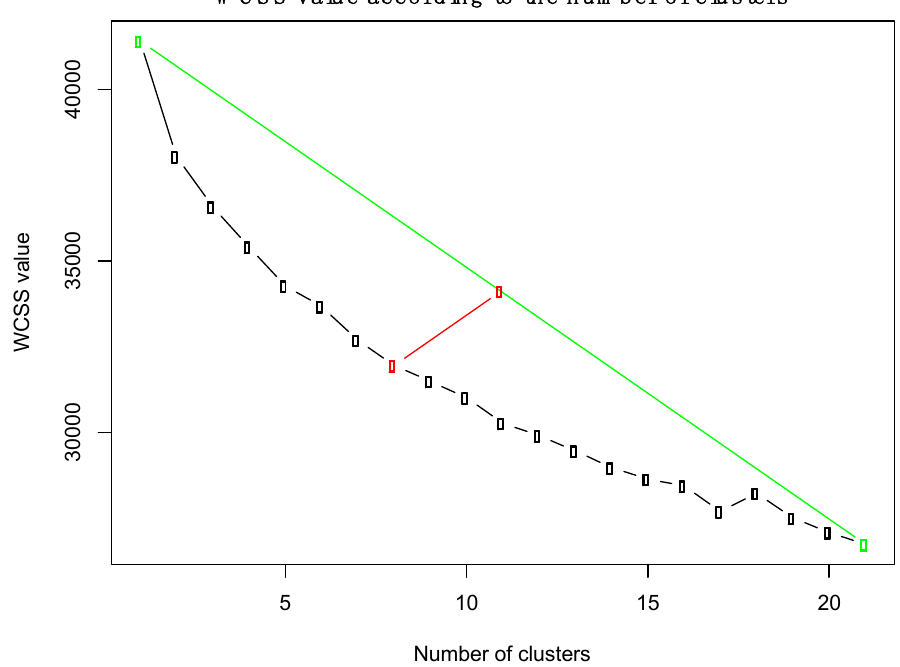
Figure 6. Within-cluster sum of squares (WCSS) errors for the K-means clustering algorithm, according to the number of clusters. The green line connects the first and last point of the WCSS curve. The red line is the “elbow” point, which is the maximum distance between the WCSS curve and the green line.